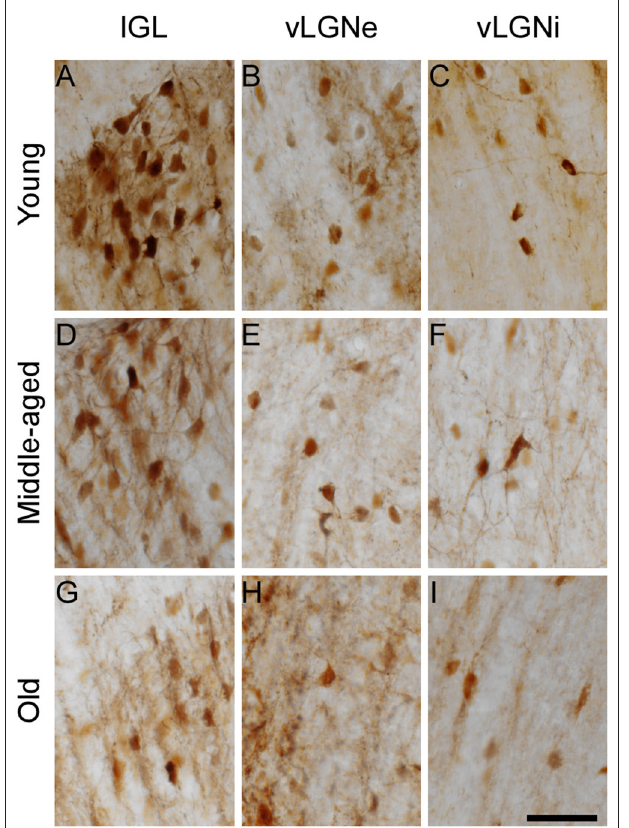
FIGURE 3 | High-magnification photomicrographs of CR immunolabeled cells of the IGL, vLGNe, and vLGNi at ZT 12. The IGL, vLGNe, and vLGNiCR + neurons from young (A–C) , middle-aged (D–F) , and old (G–I) animals are shown in detail. Scale bar = 50 µ m.